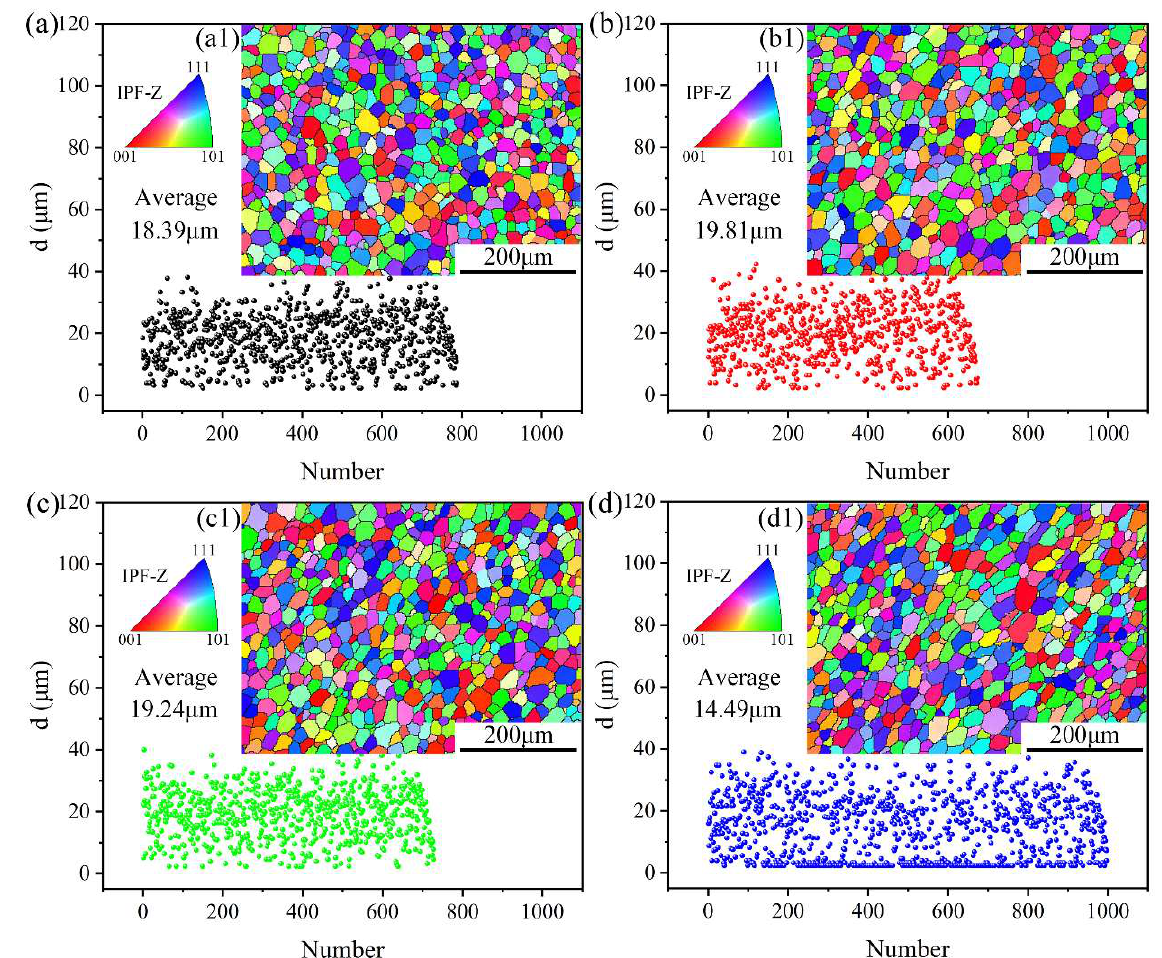
Figure 7. Grain size and IPF detection results of the AlCoCrFeNi components before and after high-temperature treatment: ( a , a1 ) as-fabricated; heat-treated at ( b , b1 ) 600 °C; ( c , c1 ) 800 °C; and ( d , d1 ) 1000 °C.